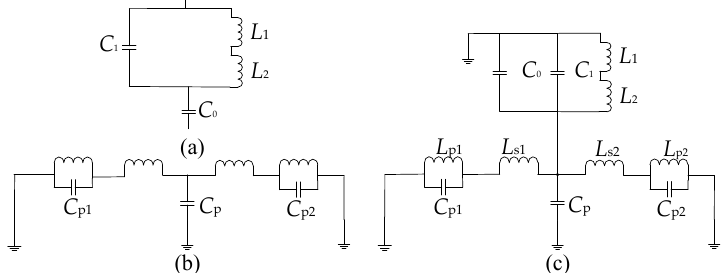
Figure 12. ( a ) The equivalent circuit of Archimedean spiral electromagnetic bandgap structure (ASEBG)